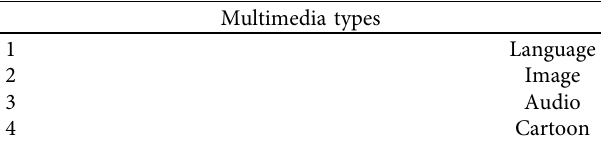
Table 1: Multimedia types.